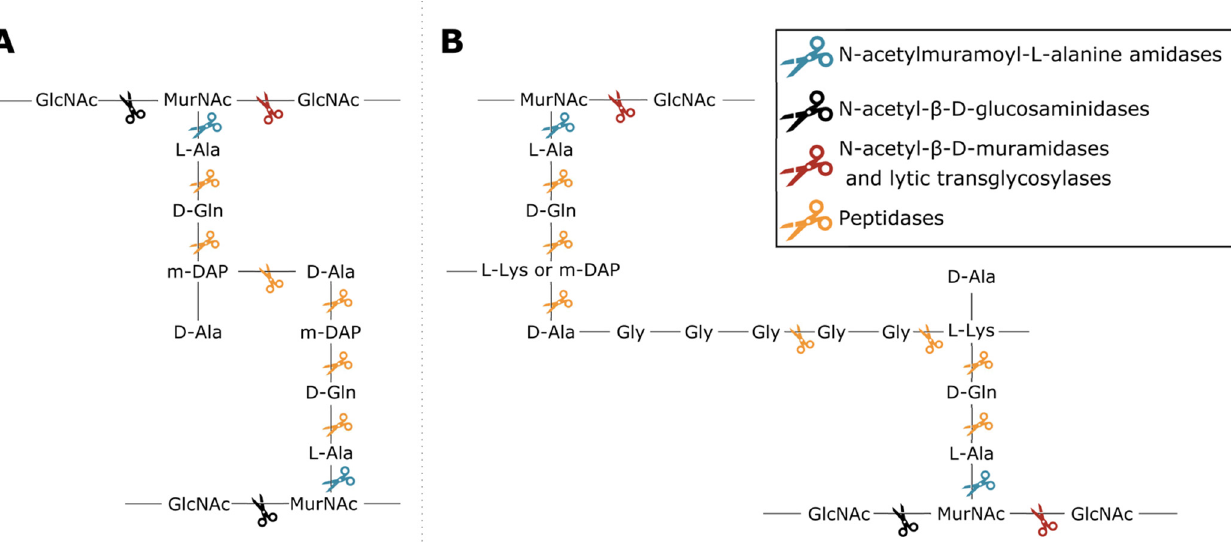
Figure 1. Cleavage sites of the different enzymatic classes of EADs on the primary structures of two common peptidoglycan types. ( A ) peptidoglycan chemotype A1 γ is the most common in Gram-negative bacteria; ( B ) peptidoglycan chemotype A3, either α or γ depending on the presence of L-Lys or mDAP in the third position of the peptide subunit, is a type example for Gram-positive bacteria such as Staphylococcus aureus [10]. The colored scissors indicate cleavage sites of different classes of EADs. GlcNAc and MurNAc in the glycan strands of each structure refer to N-acetylglucosamine and N-acetylmuramic acid, respectively.